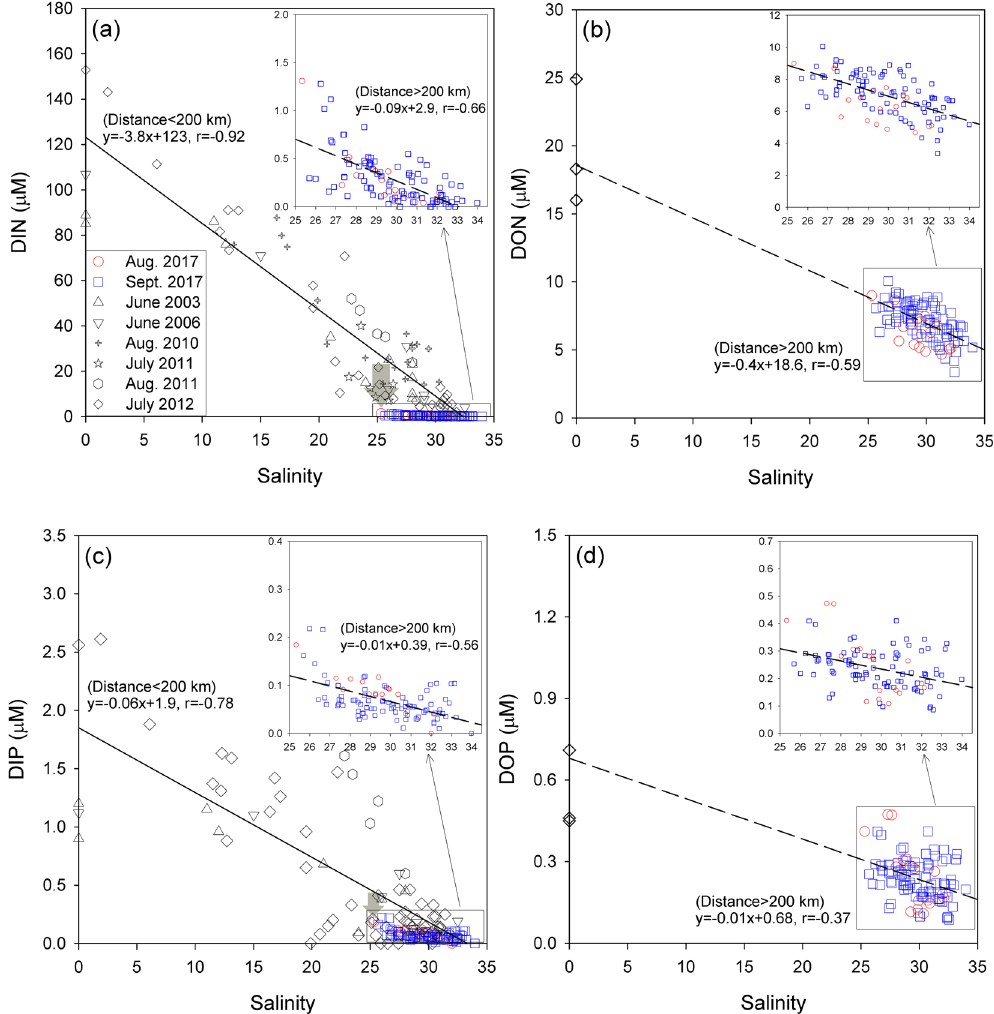
Figure 4. Scatterplots of ( a ) DIN, ( b ) DON, ( c ) DIP, and ( d ) DOP versus salinities in surface waters of the Changjiang estuary and East China Sea. The reference data between 2003 and 2012 are obtained from Chen et al . 17,18 , Gao et al . 19 , Liu et al . 26,27 , and Shen and Liu 28 . The solid lines indicate the relationship between salinity and inorganic nutrients from the Changjiang estuary (0 km) to 200 km. The dashed lines indicate the relationship between salinity and inorganic nutrients or organic nutrients from 200 to 800 km. The gray filled arrows denote the removed DIN and DIP from the expected concentrations by conservative